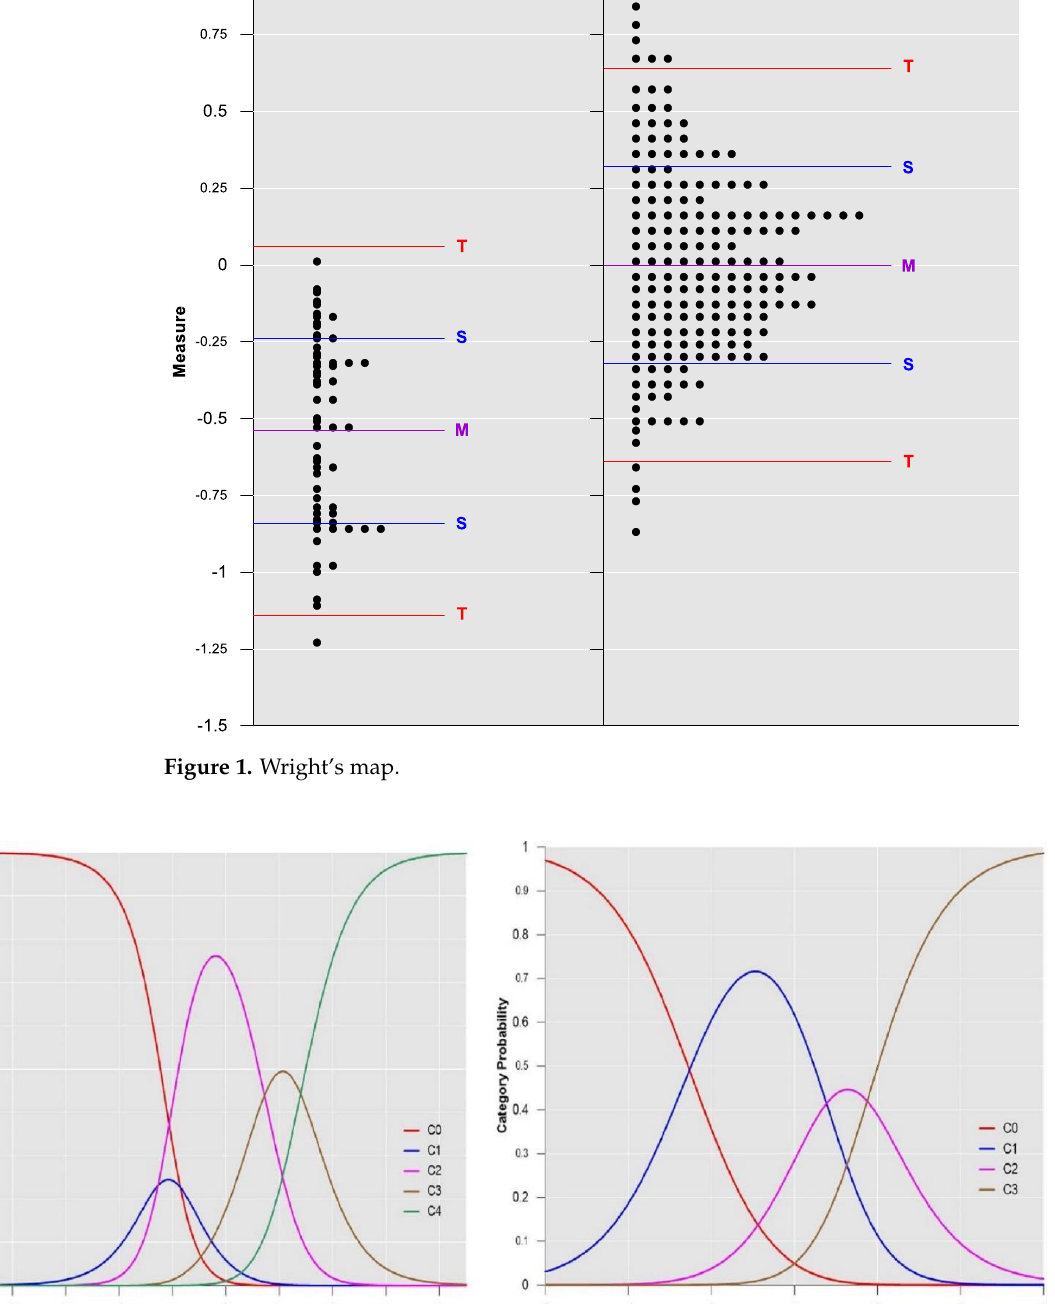
Figure 2. Rating scale category probability curves. The left side represents iteration 1: C0 = strongly disagree; students need far less support than described; C1 = disagree; students need less support than described; C2 = agree; C3 = disagree; students need more support than described; C4 = strongly disagree; students need far more support than described. Right side depicts iteration 4 (with collapsed categories): C0 = less support than described; C1 = agree; C2 = disagree; students need more support than described; C3 = strongly disagree; students need far more support than